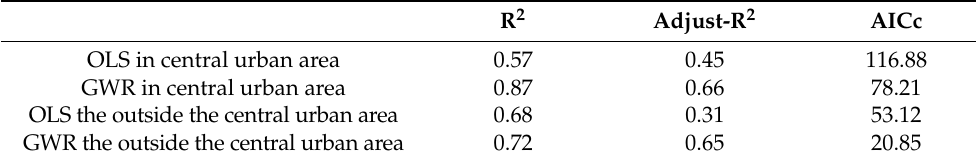
Table 4. Comparison of fitting parameters between GWR and OLS models.